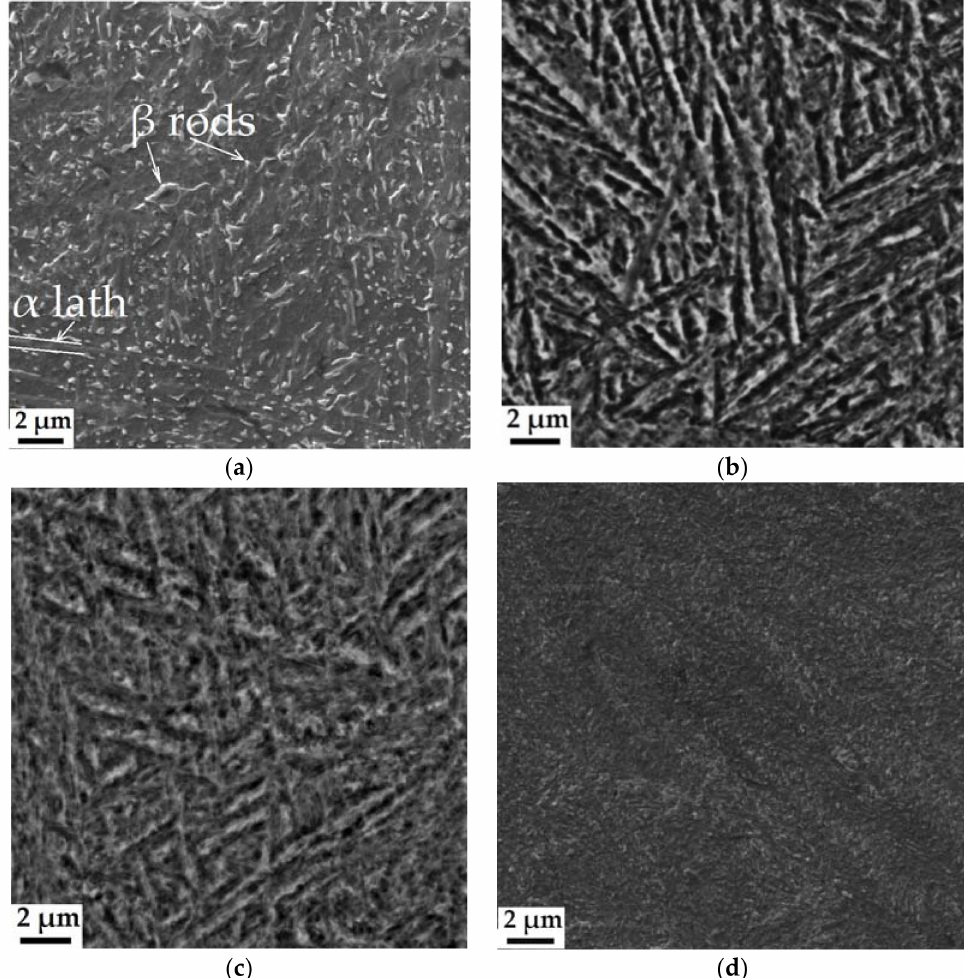
Figure 3. Scanning electron microscopy (SEM) images of EBM Ti-6Al-4V parts: ( a )—initial state ( b )—hydrogen content 0.29 wt. %; ( c )—hydrogen content 0.58 wt. %; ( d )—hydrogen content 0.9 wt.